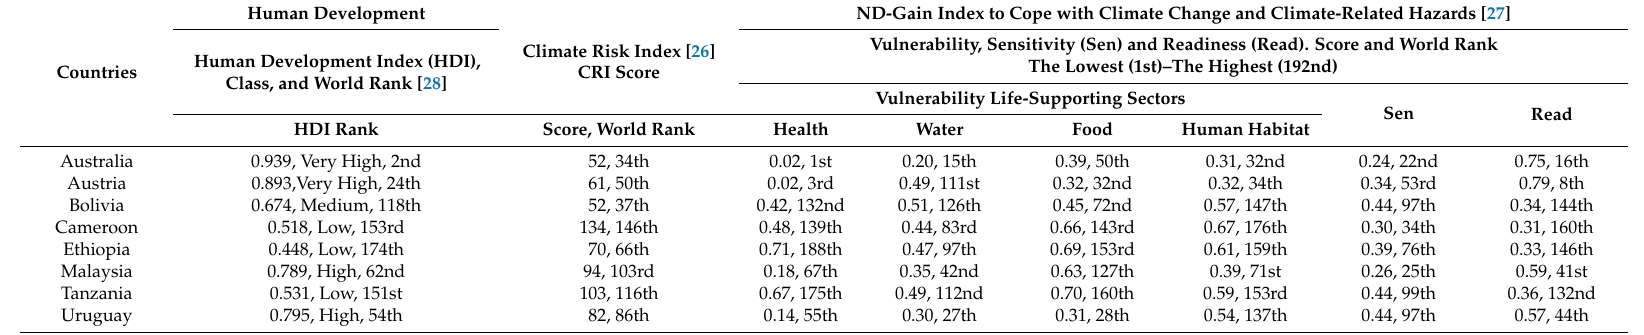
Table 2. Comparative country-level socioeconomic, vulnerability, climate-risk and adaptive capacity status of the surveyed examples. Climate Risk Index (CRI) 2017: average 1996–2015. CRI score, fatalities/100,000 inhabitants, losses per unit GDP. Vulnerability (health, water, food, human habitat sectors, sensitivity to climate-related hazards), and readiness (Read): The lower the values, the lower the risks and impacts. Human Development ND-Gain Index to Cope with Climate Change and Climate-Related Hazards [27] Vulnerability, Sensitivity (Sen) and Readiness (Read). Score and World Rank Climate Risk Index [26] Human Development Index (HDI), The Lowest (1st)–The Highest (192nd) Countries CRI Score Class, and World Rank [28] Vulnerability Life-Supporting Sectors Sen Read HDI Rank Score, World Rank Health Water Food Human